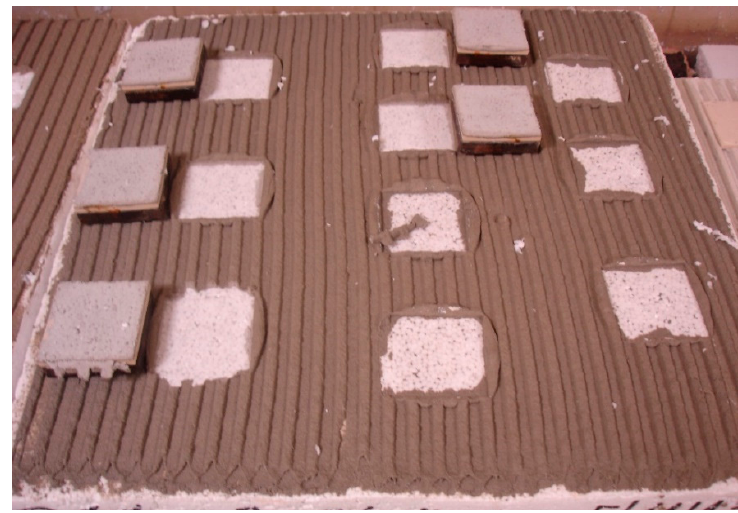
Figure 5. Adhesive strength in EPS (expanded polystyrene) substrate after water immersion (B1).